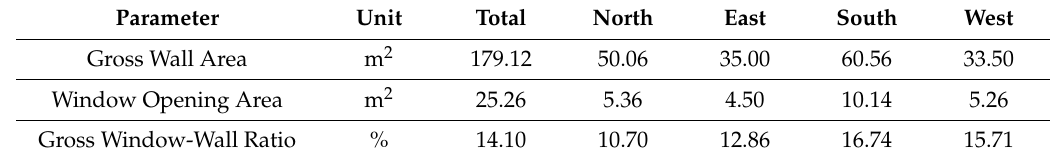
Table 2. Window to wall ratio.